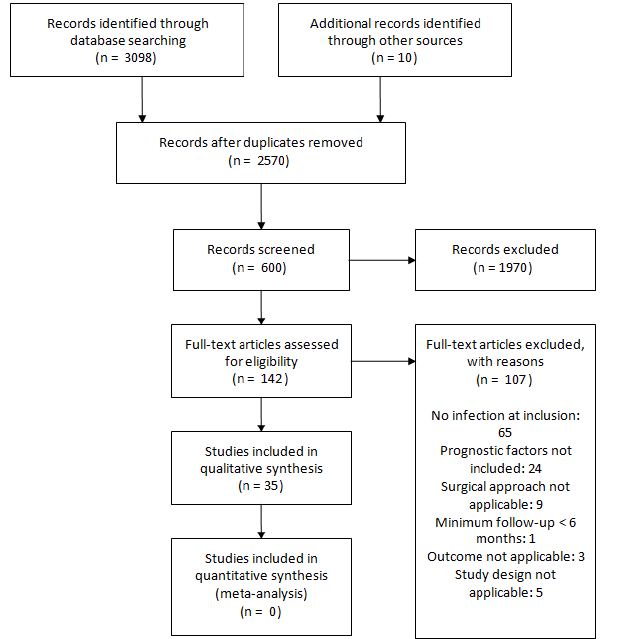
Figure 1. PRISMA 2009 study inclusion